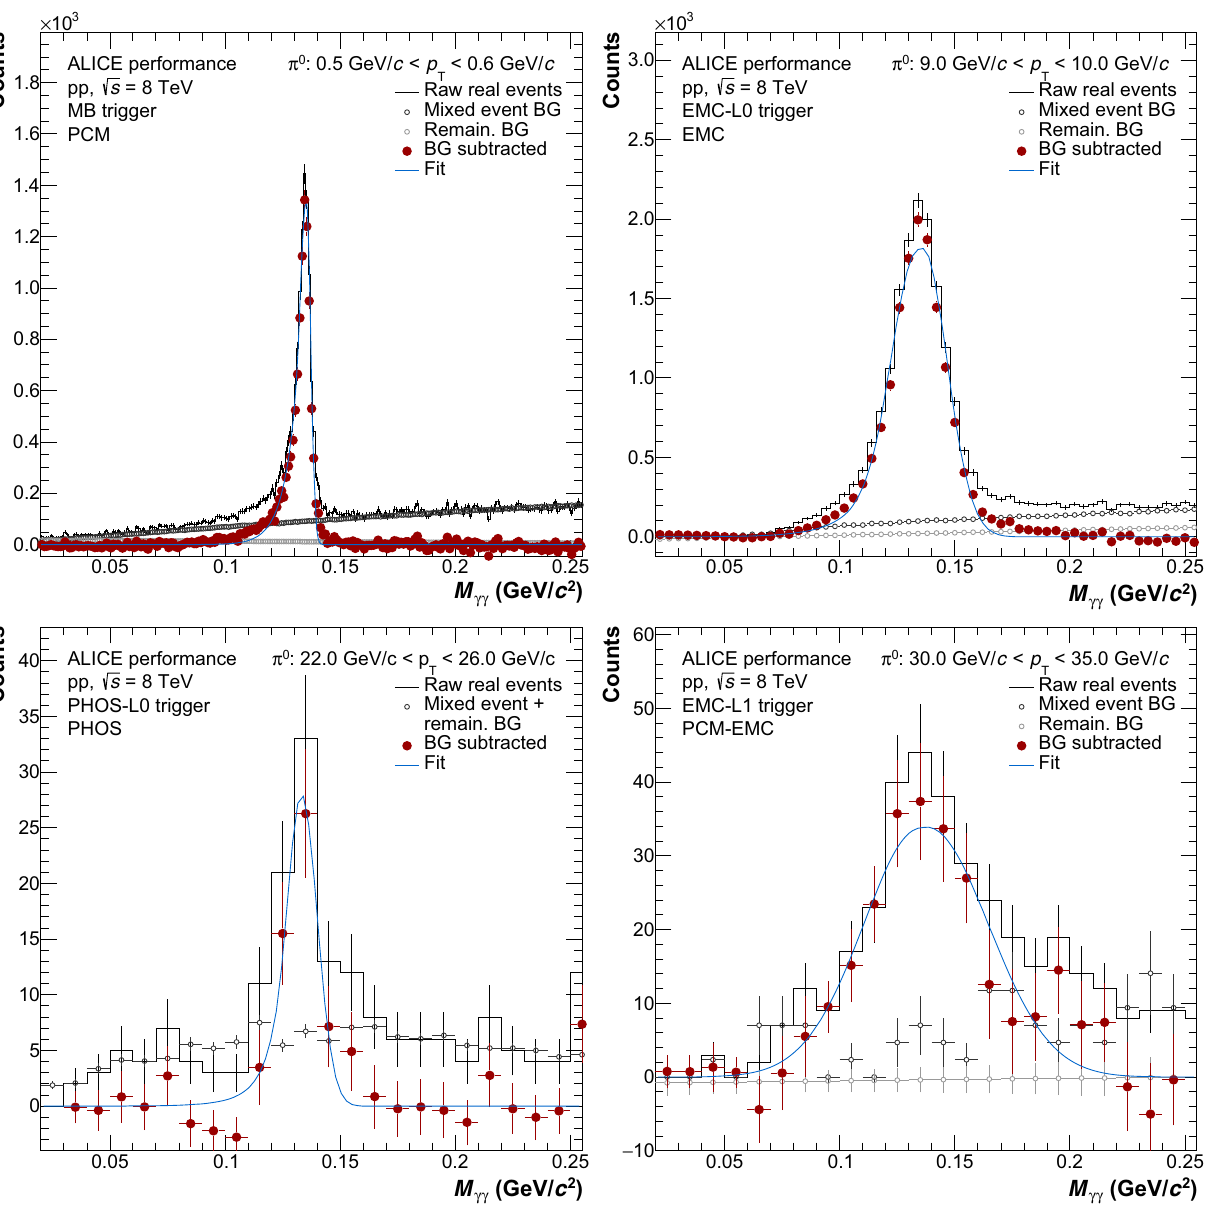
Fig. 2 Example invariant mass spectra in selected p T slices for PCM (topleft),PHOS(topright),EMC(bottomleft)andPCM-EMC(bottom right) in the π 0 mass region. The black histograms show raw invariant mass distributions before any background subtraction. The grey points show mixed-event and residual correlated background contributions,